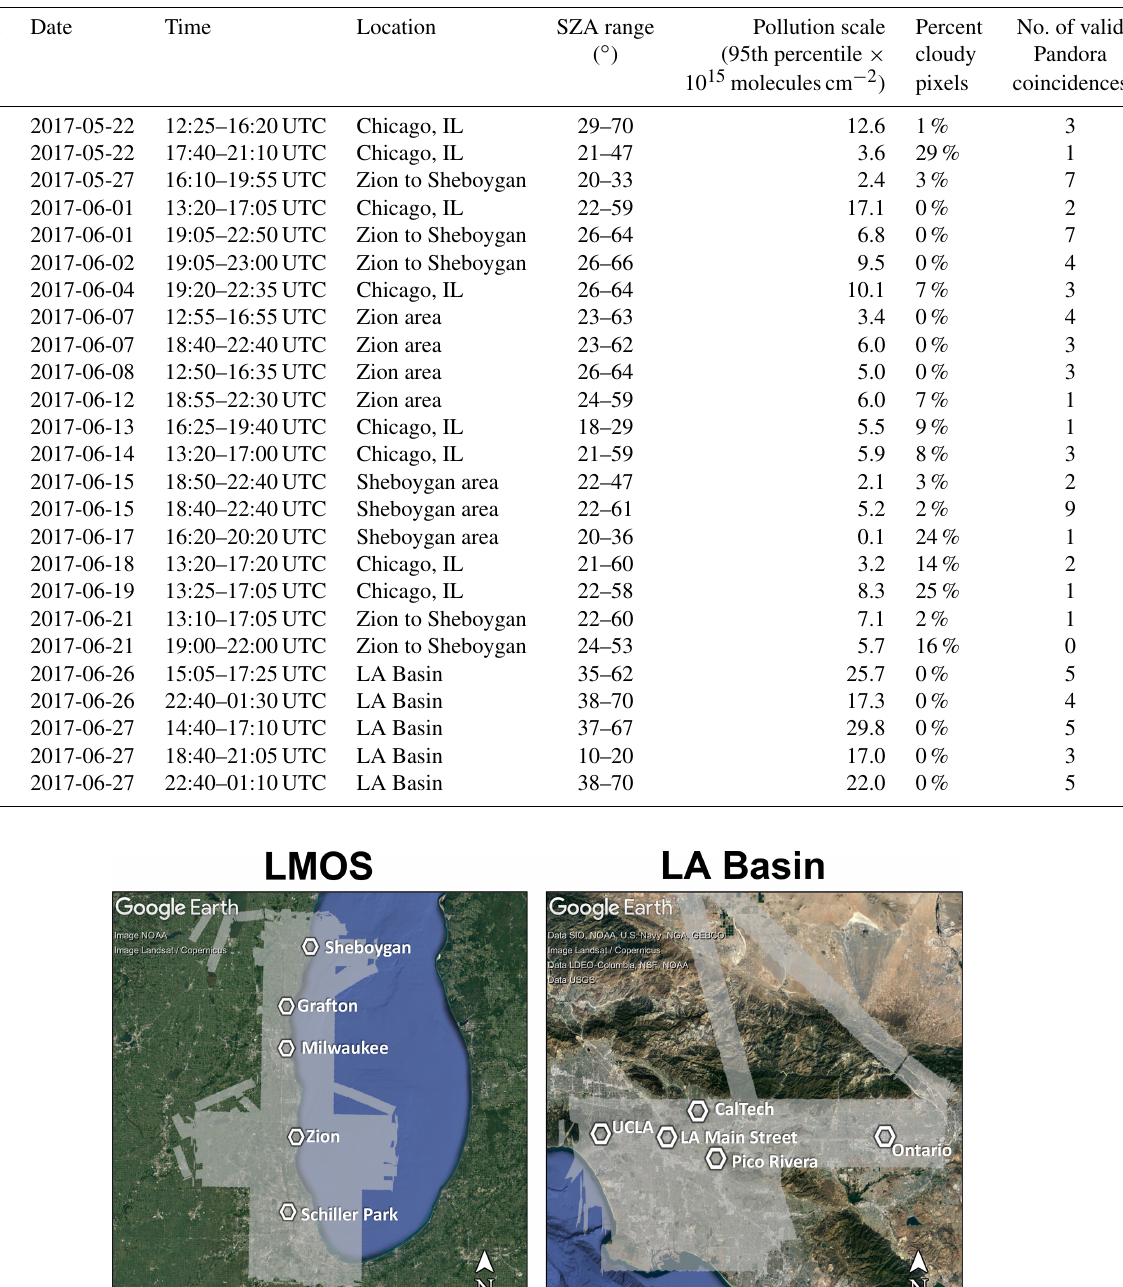
Table 1. GeoTASO flight summary.